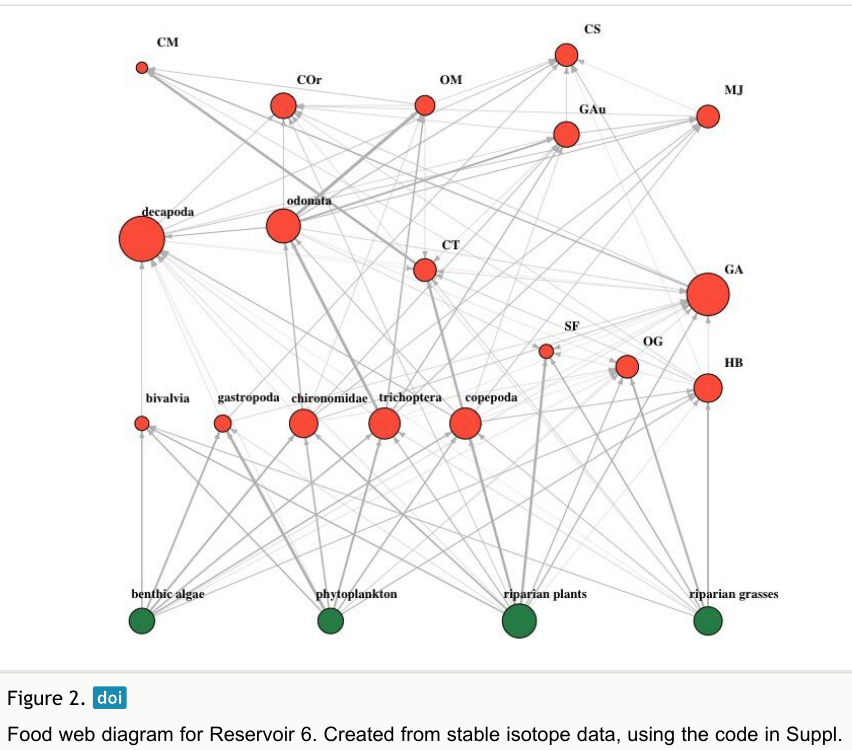
Food web diagram for Reservoir 6. Created from stable isotope data, using the code in Suppl. material 1 and data in Suppl. material 2. The size of each node representing individual taxa is indicative of the number of links formed with other taxa (larger nodes indicate more links), while the thickness of arrows representing predator-prey relationship indicates the relative interaction strengths (thicker arrows indicate greater